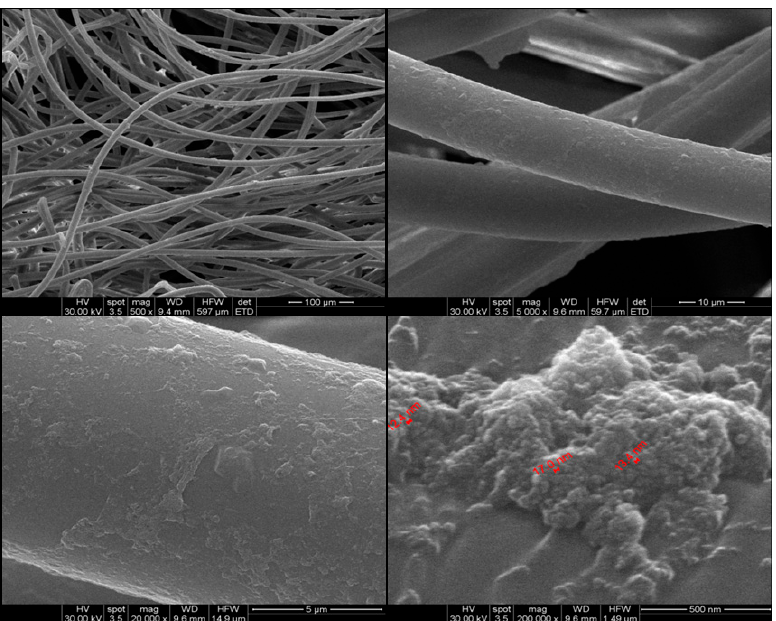
Figure 3. SEM images of coated wound